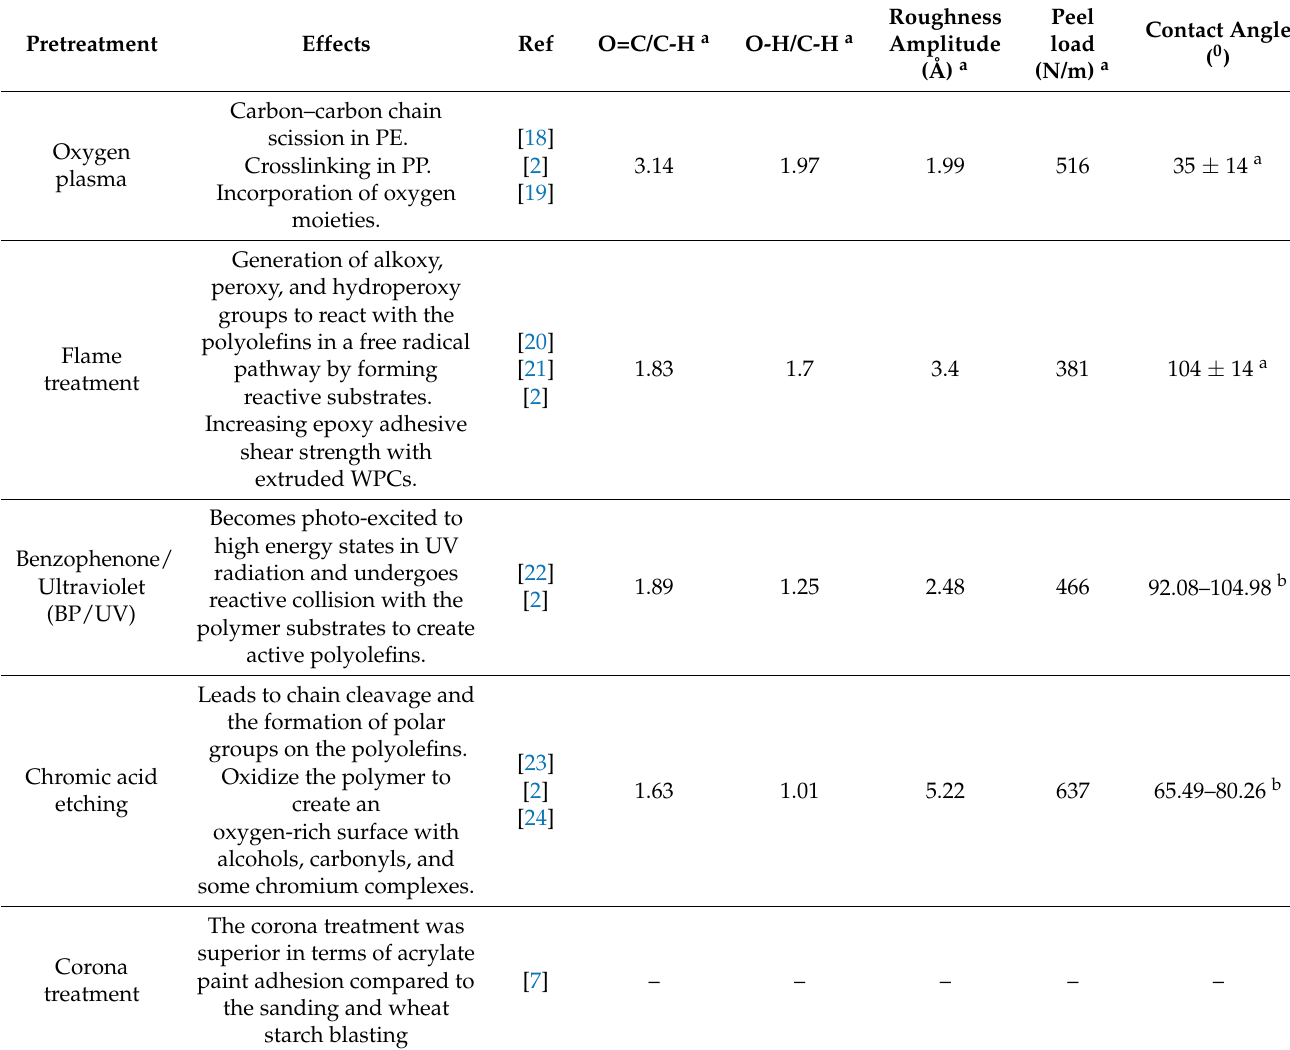
Table 1. Effect of different surface treatments on the surface properties of wood–polymer composites.